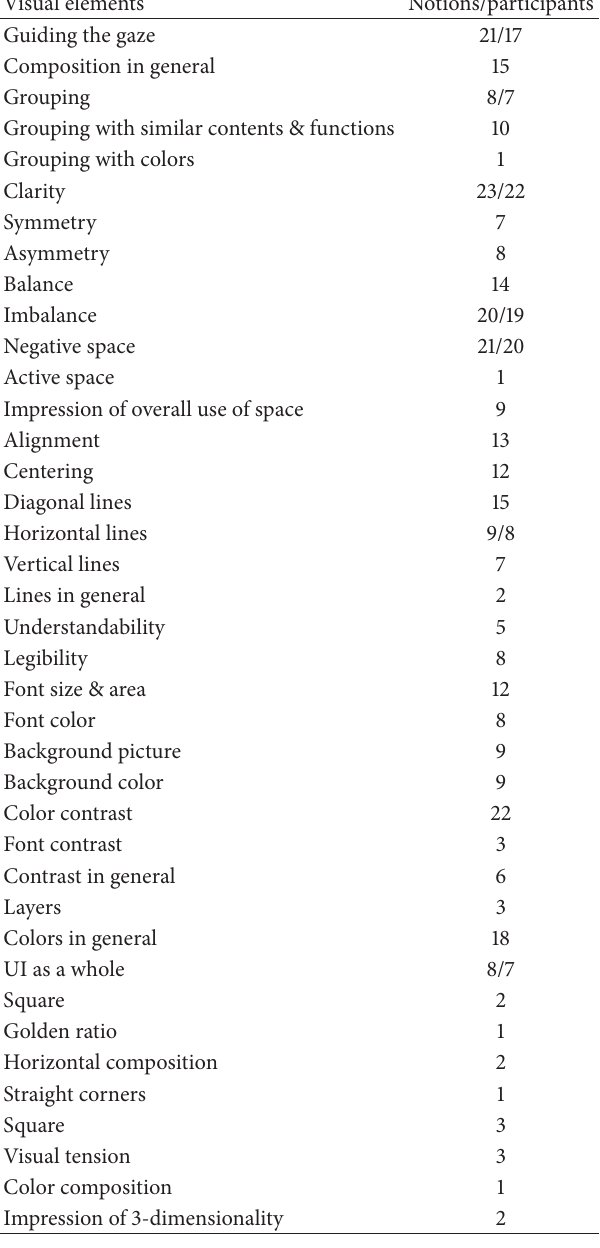
Table 1: Notions of visual elements by